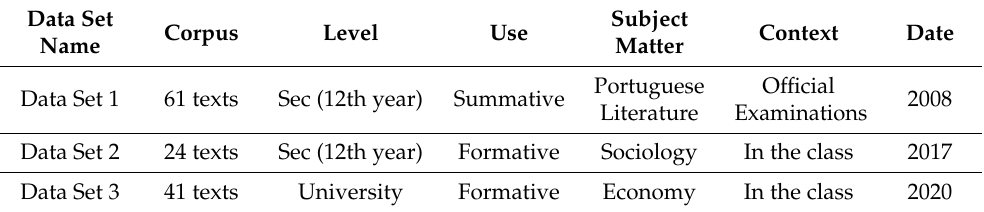
Table 1. Synthesis of features of data sets used for data